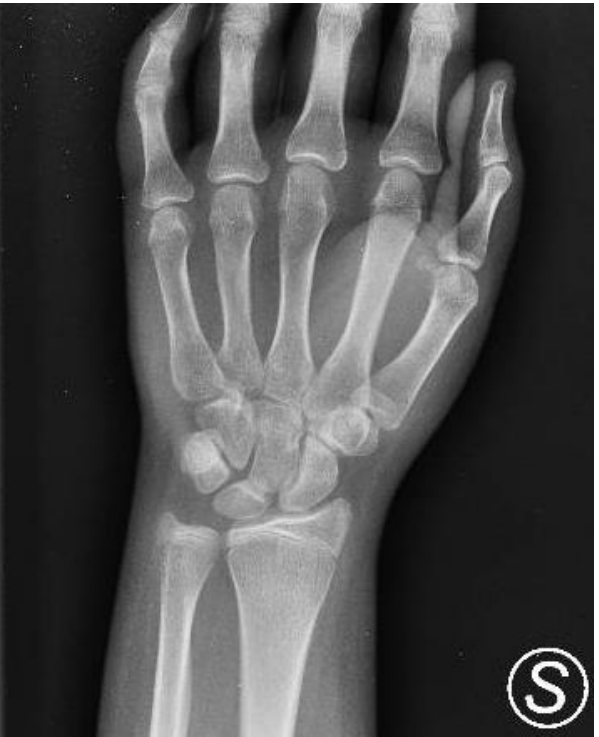
Figure 1. X-ray of the left wrist. Images not attributable to periosteal reaction.